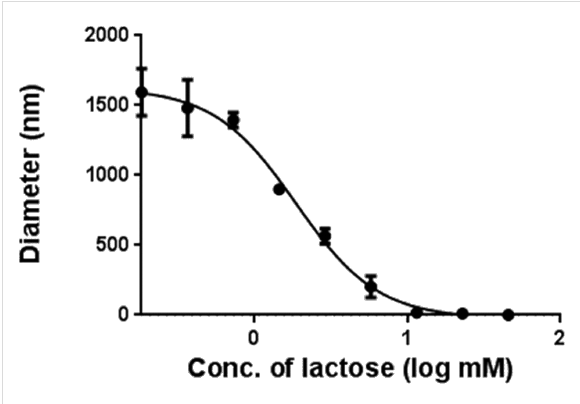
Figure 6: Lactose inhibition of galectin-1 nanoparticle formation with compound 4 .